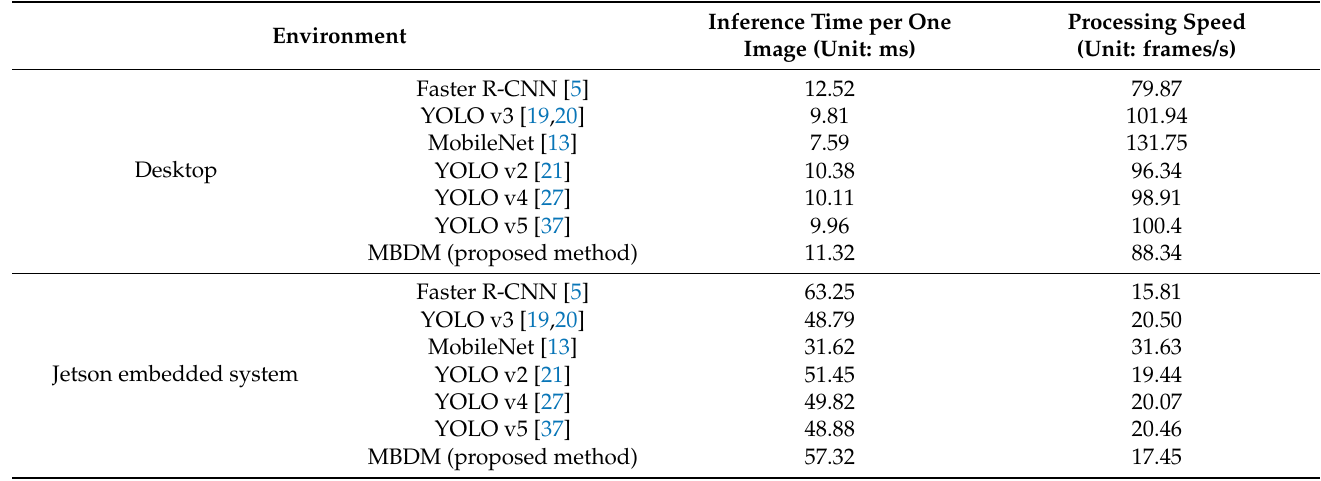
Table 13. Comparisons of inference time and processing speed by proposed method and the state-of- the-art methods.